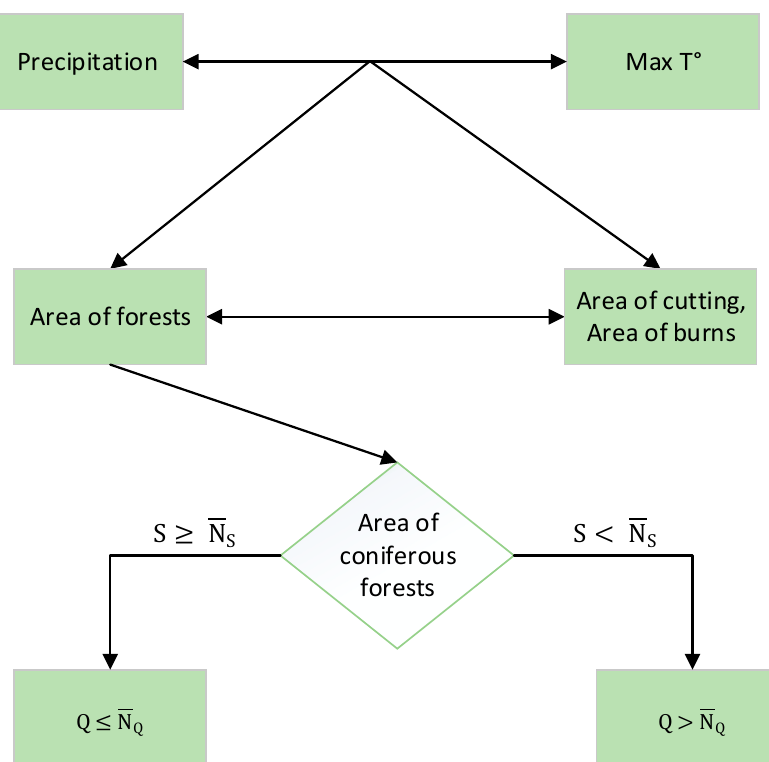
Figure 4. A conceptual map of the impacts on streamflow of climatic and human activities factors in the study region. S—percentage of coniferous (%), N S —average S of 2000–2016; Q—module of discharge, N Q —average Q of 2000 ‐ 2016.